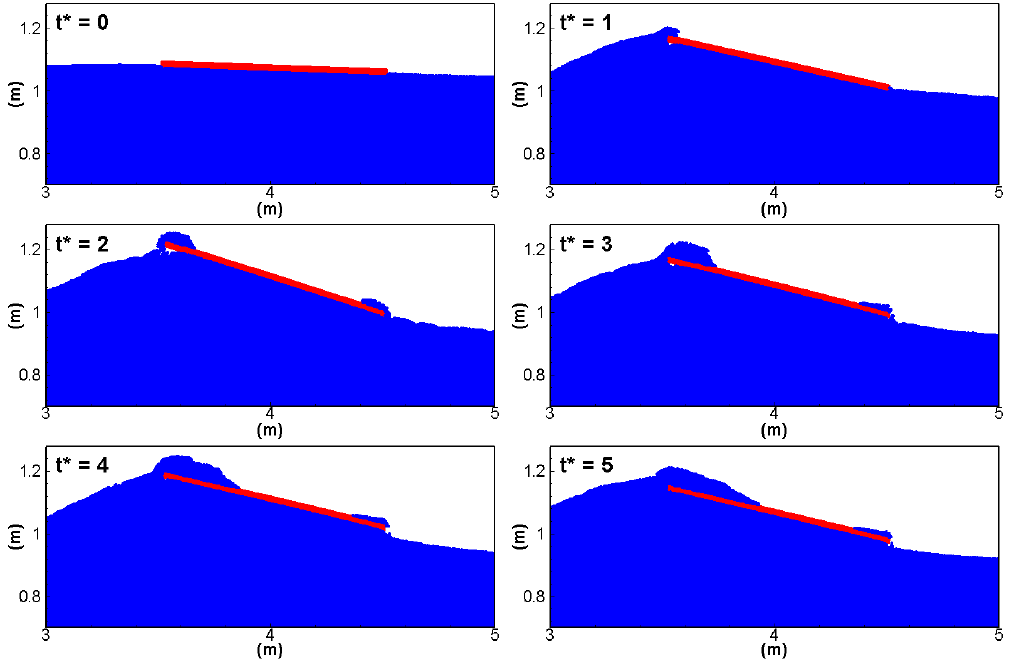
Figure 5. Dynamics of the floating plate with Young modulus E = 2.5 GPa under less severe wave conditions with wave steepness ka = 0.295. Ratio of the plate length to the wavelength is 2 L / λ = 0.3.